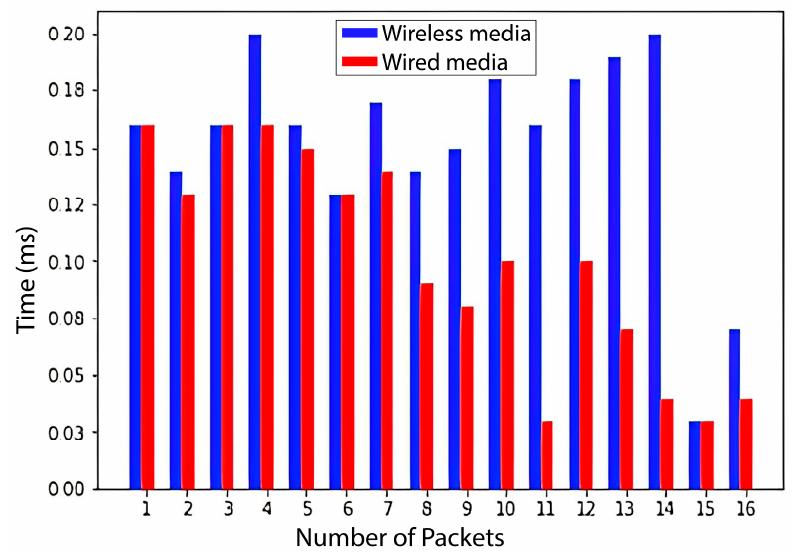
Figure 8. Packets sent from/to the server.